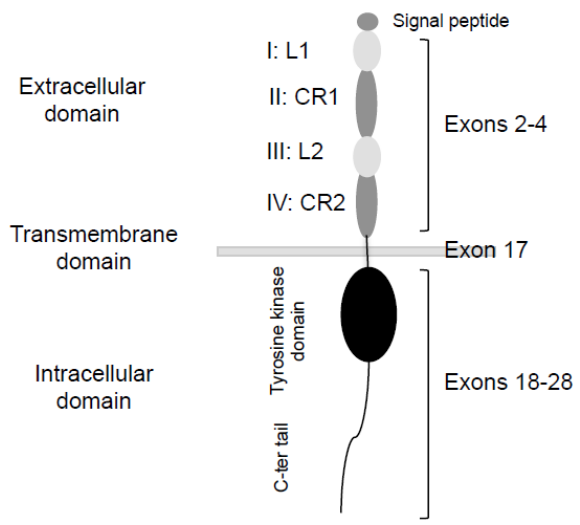
Figure 1. Schematic structure of the EGFR monomer. L: Ligand binding domain. CR: Cysteine-rich domain.